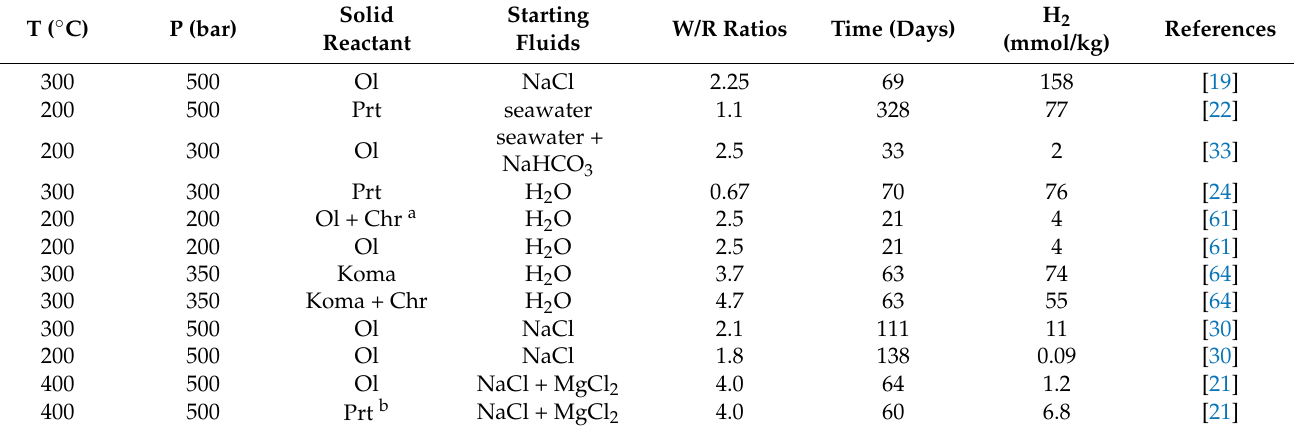
Table 2. The production of H 2 in previous experimental